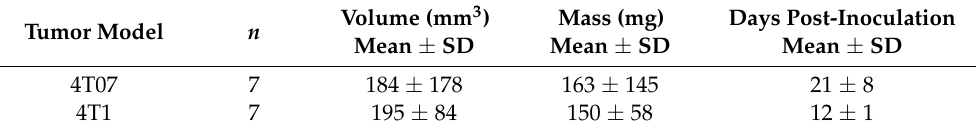
Table 1. Estimated tumor volumes and measured tumor masses for both metastatic dormant 4T07 and metastatic proliferative 4T1 tumor